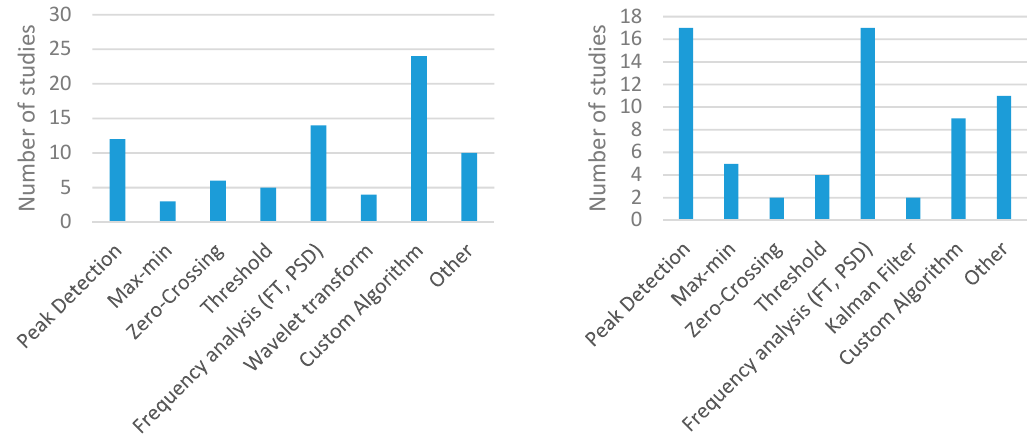
Figure 34. Number of studies using different processing algorithms for the wearable ( left ) and environmental ( right ) categories.